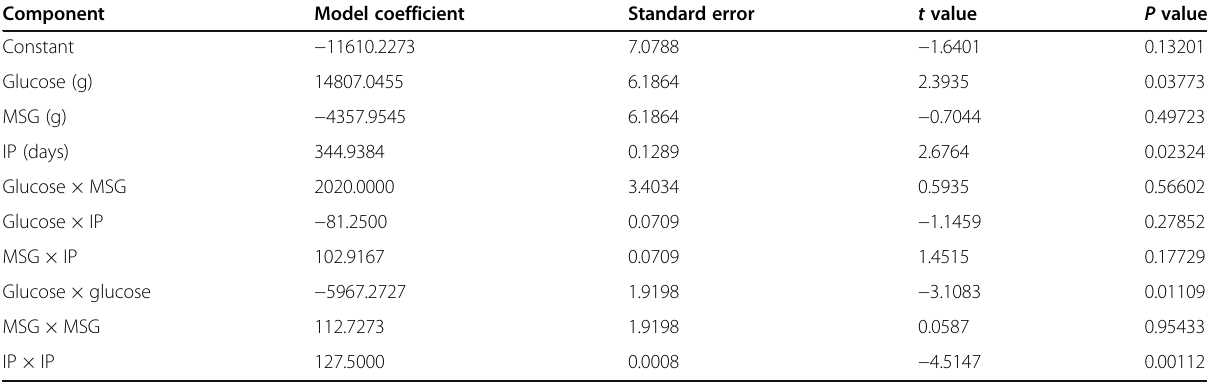
Table 4 Regression co-efficient results from the data of CCD (central composite design) experiments for GABA ( γ -aminobutyric acid)